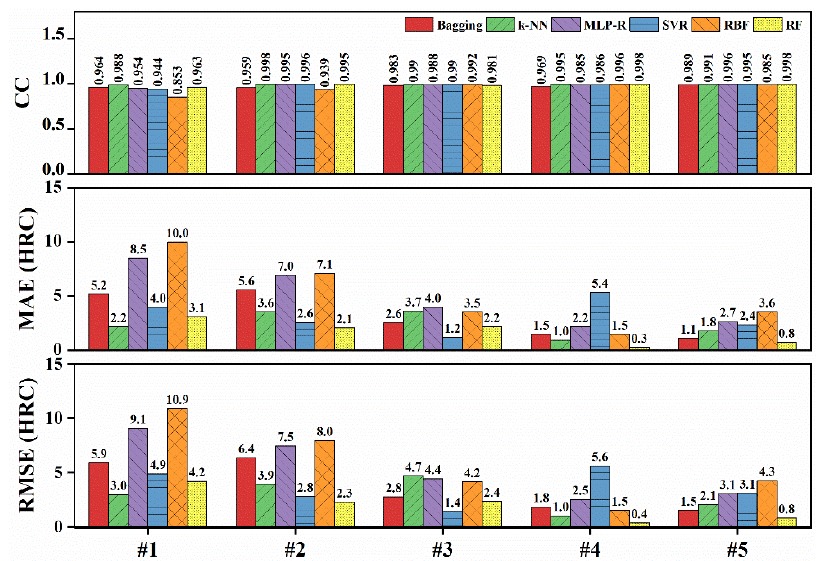
Figure 6. Correlation coefficients and error values of the prediction result on the test sets.